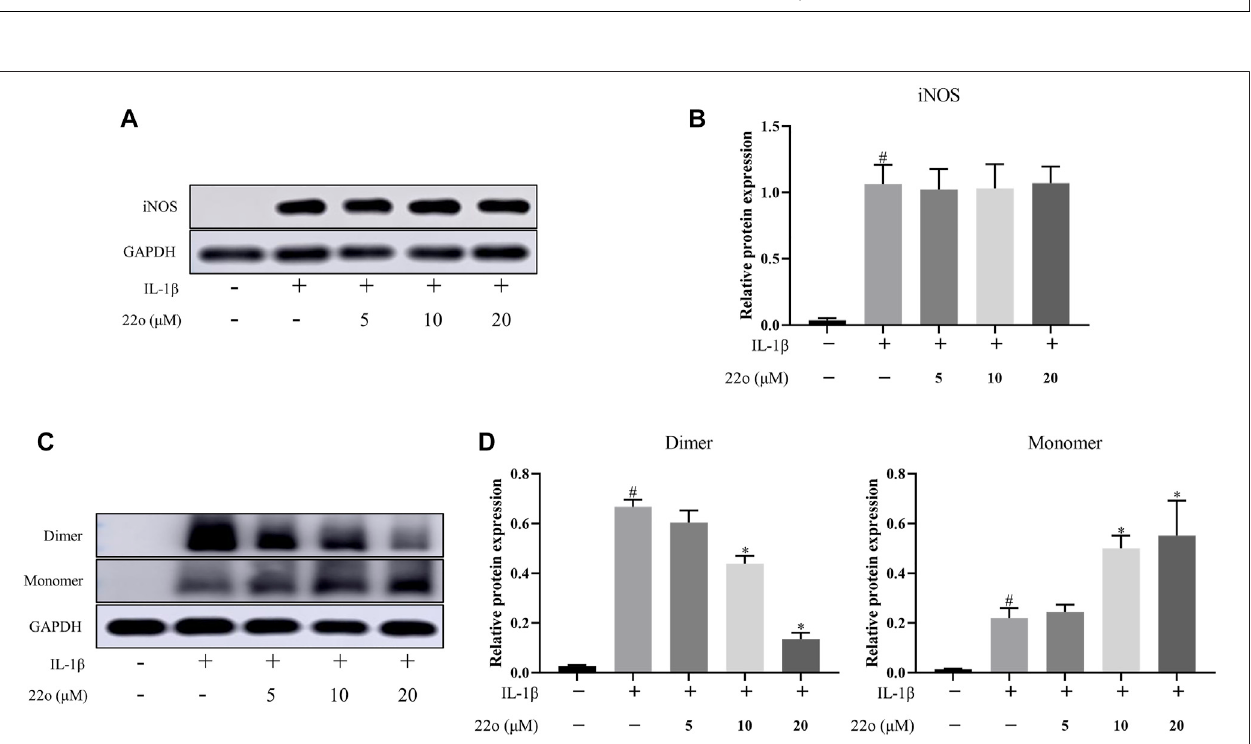
FIGURE3| Compound22oinhibitstheformationofiNOSdimer.Ratchondrocytesweretreatedwithdifferentconcentrationsofcompound22ointhepresenceor absenceofIL-1 β (10 ng/ml)for24 h. (A) Westernblotsand (B) quantitativeanalysisofiNOS. (C) Westernblotsand (D) quantitativeanalysisofiNOSdimerandmonomer. GAPDH was employed as the internal control ( n = 3). # p < 0.05 vs. control group; * p < 0.05 vs. IL-1 β group.